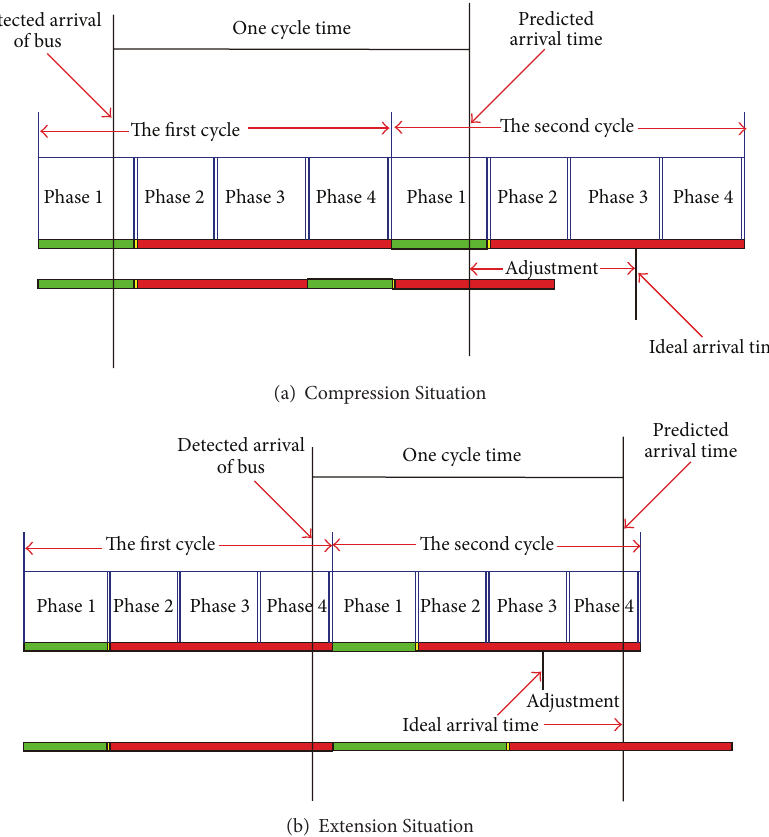
Figure 4: Illustrations of Adjustment between the Predicted and Target Arrival